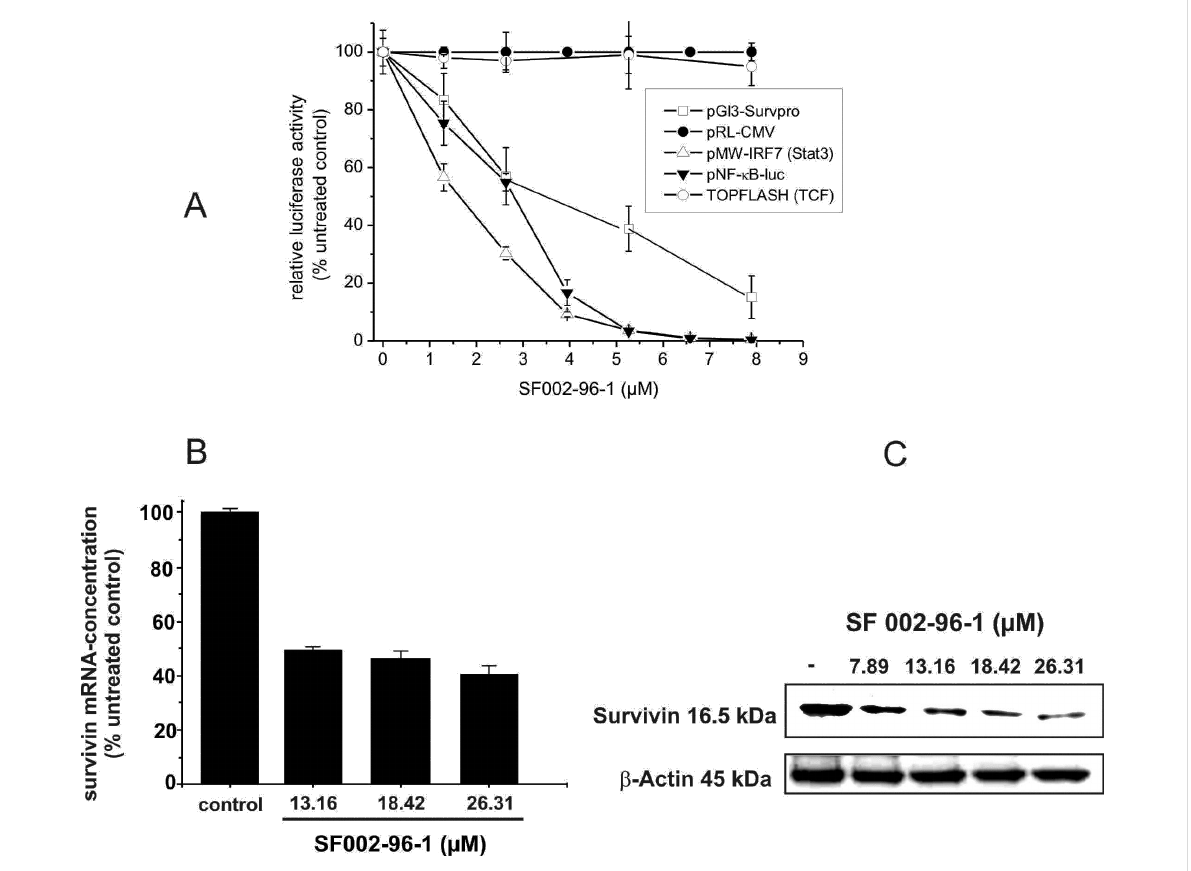
Figure 4: Effect of SF002-96-1 on survivin promoter activity, survivin mRNA levels and expression. (A) Colo 320 cells were transiently transfected with a human survivin-, CMV-, or β -catenin/TCF-dependent reporter construct for 24 h with or without test compound. Control (100%): untreated cells only. For NF- κ B- and Stat3-driven reporter gene expression, cells were transfected with the indicated reporter gene construct and stimulated with 10 ng/mL TNF- α , 5 ng/mL IL-1 β (for pNF- κ B-luc) or 10 ng/mL IL-6 (for Stat3 dependent pMW-IRF7) with or without test compound for 24 h. Control: (100%): stimulation only. Results represent the mean ± SD of at least three independent experiments. The expression of the reporter gene was deter- mined as described in the experimental section. (B) Effect on survivin mRNA levels. Colo 320 cells were treated with different concentrations of SF002-96-1 for 8 h. mRNA levels of survivin were measured by real-time PCR as described in the experimental section. Control (100%): untreated cells. Results represent the mean ± SD of at least three independent experiments. (C) Western blot analysis for survivin. Colo 320 cells were treated with different concentrations of SF002-96-1 for 8 h. Subsequently total cell extracts were prepared and analyzed by Western blot analyses. β -Actin was used as internal